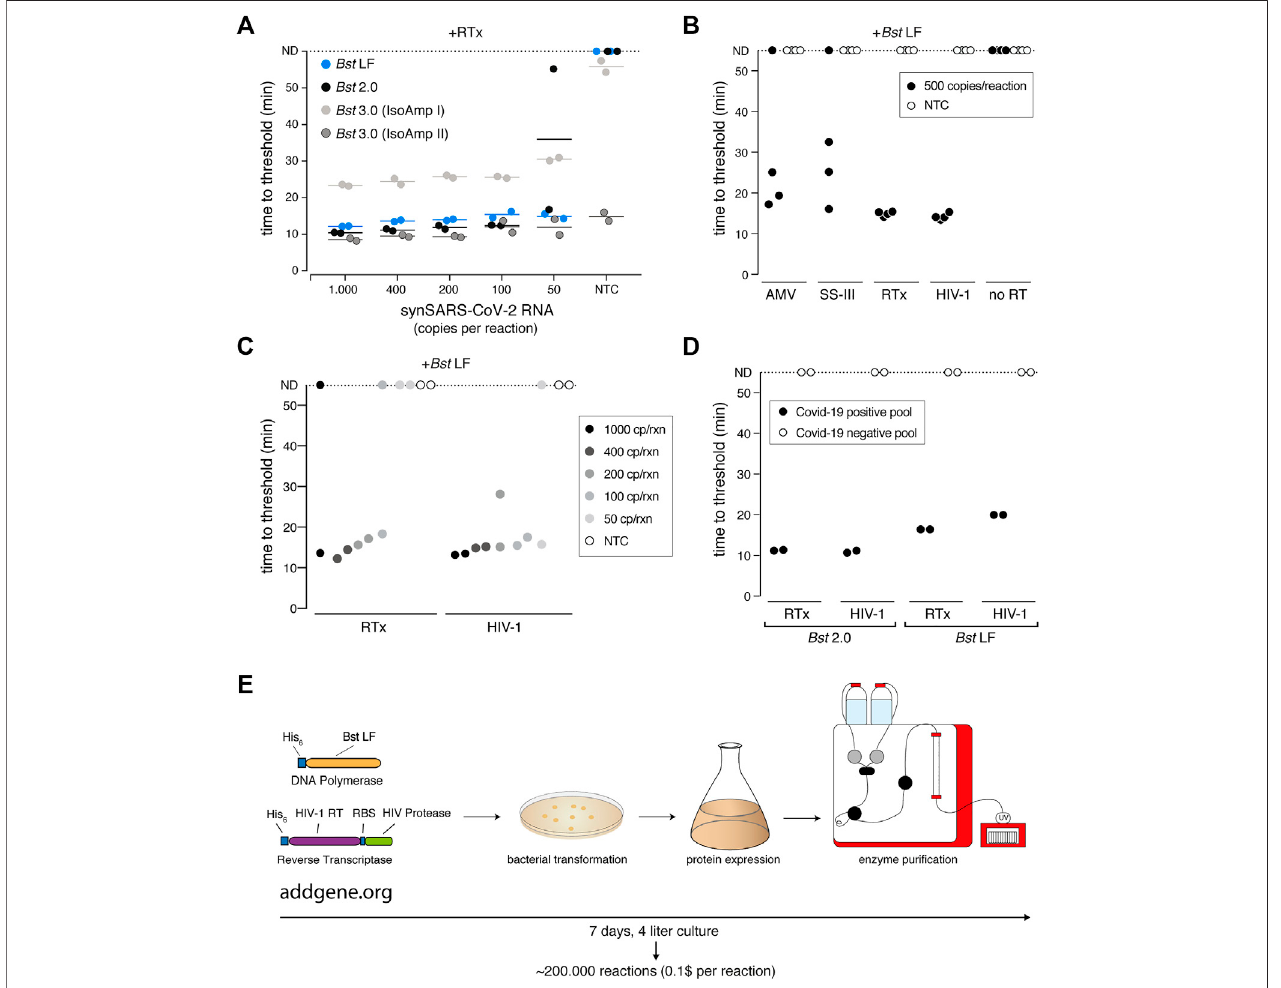
FIGURE 6 | A sensitive RT-LAMP assay based on open-access enzymes. (A) RT-LAMP performance (measured as “ time to threshold ” ) of different Bst DNA polymerase variants in combination with NEB ’ s RTx reverse transcriptase on synthetic SARS-CoV-2 RNA standard. For reactions in which no ampli fi cation was recorded, “ timetothreshold ” isreportedas “ notdetected ” (ND)throughout Figures6A – D .Reactionswereperformedinduplicates;waterwasusedasno-targetcontrol (NTC). (B) RT-LAMP performance (measured as “ time to threshold ” ) of different patent-protected (RTx, SuperScript III (SS-III)) and non-patent protected (AMV, HIV-1) reverse transcriptase enzymes in combination with Bst LF DNA polymerase on 500 copies/reaction of synthetic SARS-CoV-2 RNA standard. Reactions were performed in technical quadruplicates; water was used as no-target control (NTC) (C) RT-LAMP sensitivity performance (measured as “ time to threshold ” ) of reactions containing NEB RTx or home-made HIV-1 RT, in combination with Bst LF DNA polymerase. Reactions contained different amounts of synthetic SARS-CoV-2 RNA standard.Reactionswereperformedintechnicalduplicates;waterwasusedasno-targetcontrol(NTC). (D) PerformanceofRT-LAMP(measuredas “ timetothreshold ” ) with different enzymatic compositions and QuickExtract patient sample as input. A pool of COVID-19 positive patient crude lysates (Pool N1-CDC, Cq 25) and a pool of COVID-19 negative crude lysates were tested in technical duplicates. (E) Deployment of open-access RT-LAMP. Bacterial expression plasmids can be obtained from Addgene (https://www.addgene.org/159148/, https://www.addgene.org/159149/). HIV-1 RT and Bst LF suf fi cient for ~220.000 reactions of RT-LAMP can be obtained within 1 week, starting from 4 L of E. coli